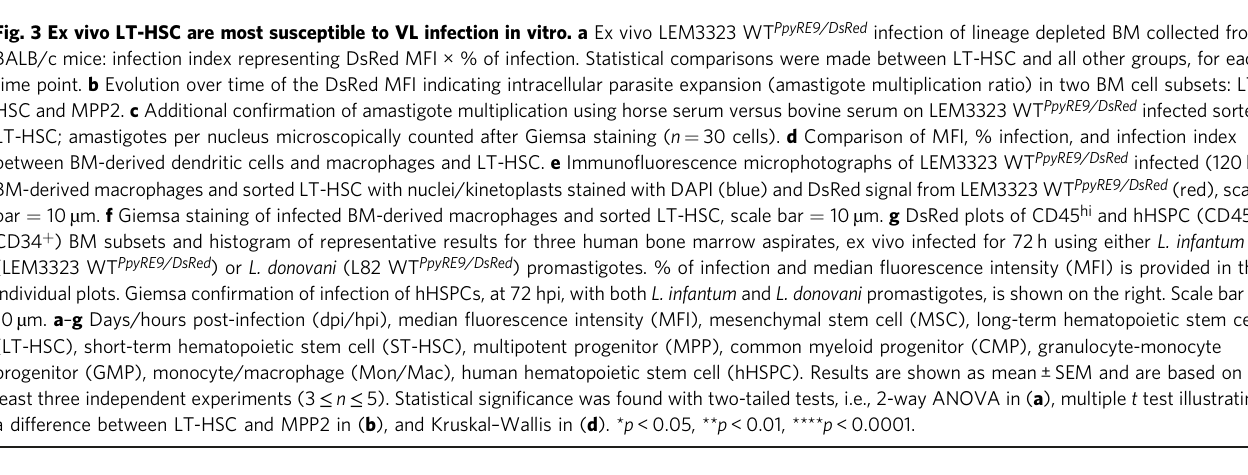
Fig. 3 Ex vivo LT-HSC are most susceptible to VL infection in vitro. a Ex vivo LEM3323 WT PpyRE9/DsRed infection of lineage depleted BM collected from BALB/c mice: infection index representing DsRed MFI × % of infection. Statistical comparisons were made between LT-HSC and all other groups, for each time point. b Evolution over time of the DsRed MFI indicating intracellular parasite expansion (amastigote multiplication ratio) in two BM cell subsets: LT- HSC and MPP2. c Additional con fi rmation of amastigote multiplication using horse serum versus bovine serum on LEM3323 WT PpyRE9/DsRed infected sorted LT-HSC; amastigotes per nucleus microscopically counted after Giemsa staining ( n = 30 cells). d Comparison of MFI, % infection, and infection index between BM-derived dendritic cells and macrophages and LT-HSC. e Immuno fl uorescence microphotographs of LEM3323 WT PpyRE9/DsRed infected (120 h) BM-derived macrophages and sorted LT-HSC with nuclei/kinetoplasts stained with DAPI (blue) and DsRed signal from LEM3323 WT PpyRE9/DsRed (red), scale bar = 10 µ m. f Giemsa staining of infected BM-derived macrophages and sorted LT-HSC, scale bar = 10 µ m. g DsRed plots of CD45 hi and hHSPC (CD45